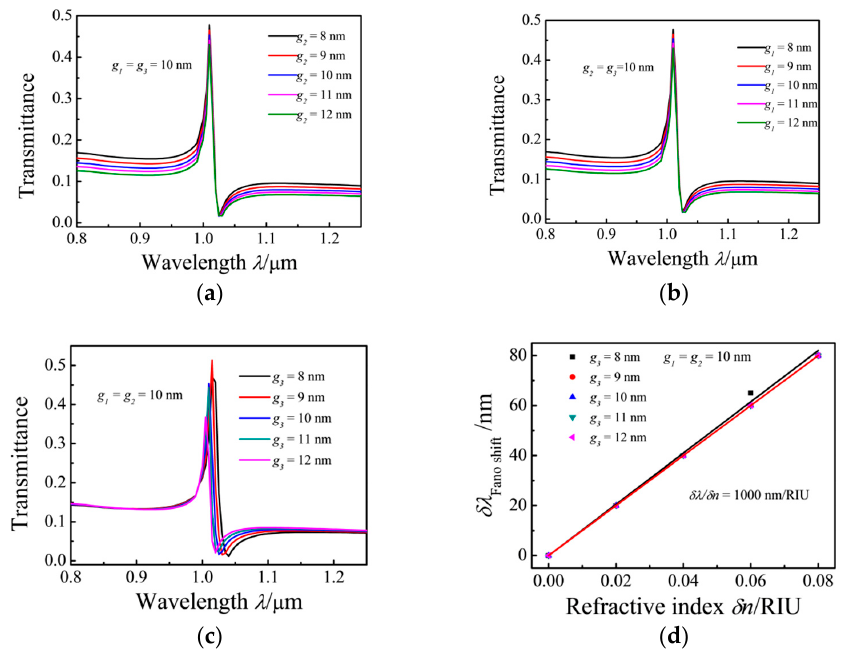
Figure 7. Transmission spectra of the MIM waveguide coupled with ring and rectangular cavities with varying coupling distances ( a ) g 2 ; ( b ) g 1 ; ( c ) g 3 and ( d ) the shift in the Fano resonance peak as a function of the refractive index change ( δ n ).